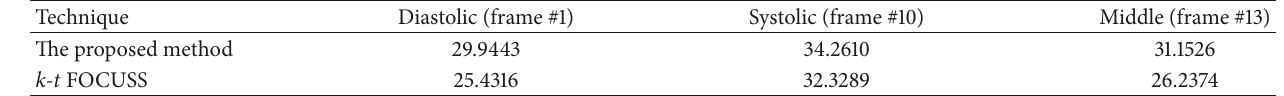
Table 2: PSNR (db) comparison for the proposed method and k-t FOCUSS with MEMC.